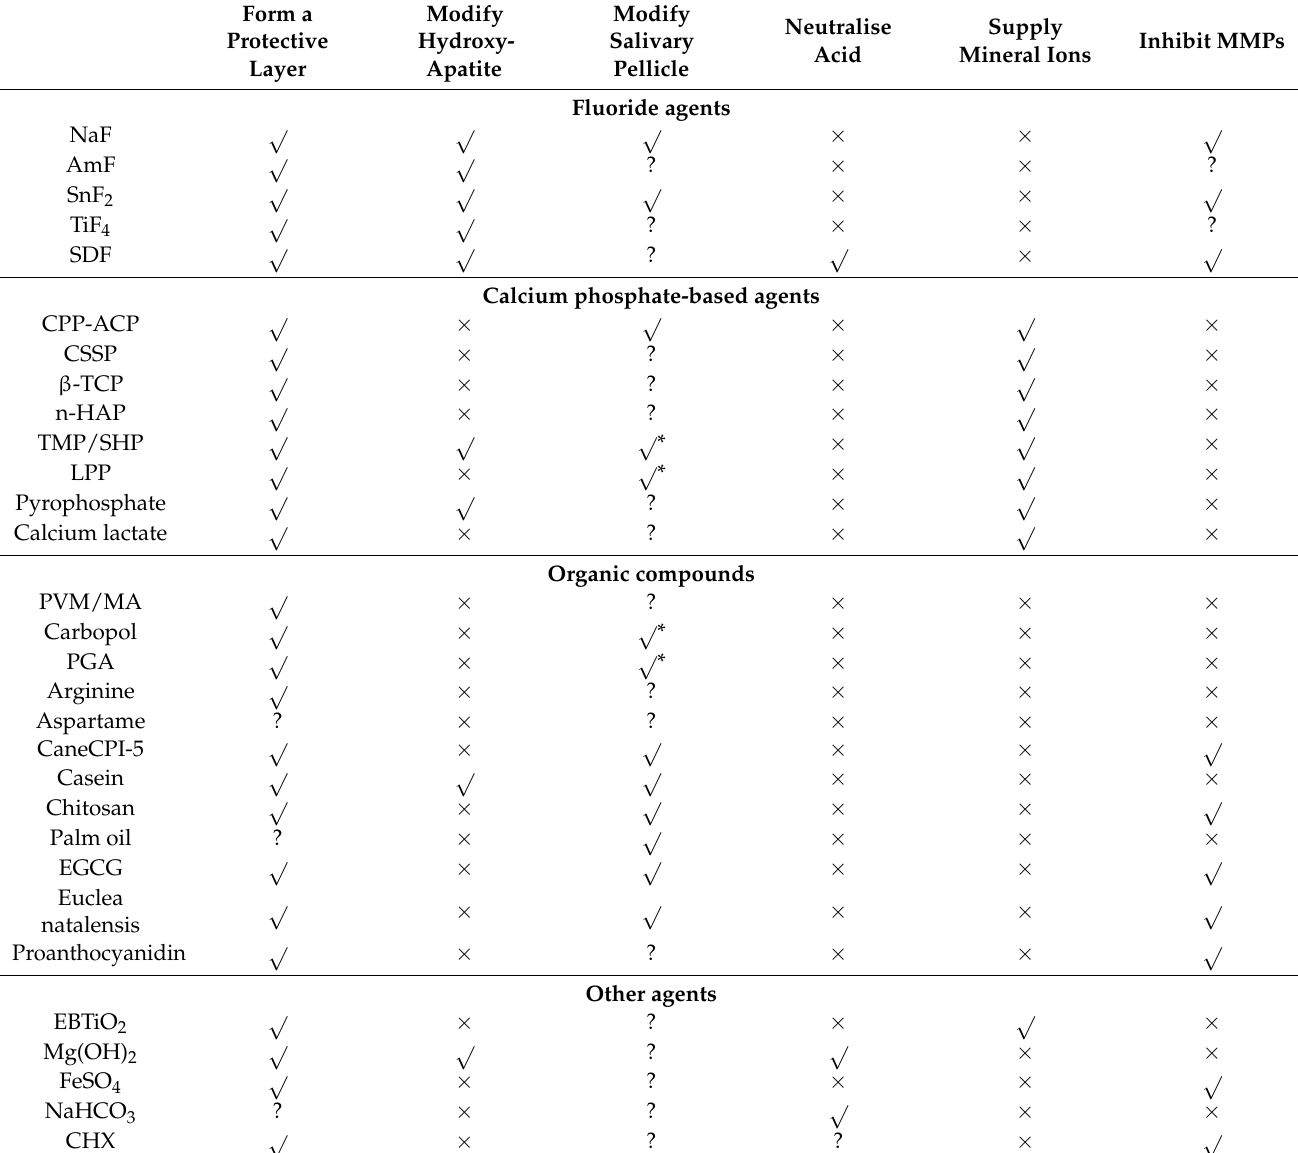
Table 2. Summary of the properties of topical anti-erosive agents in the literature. Form